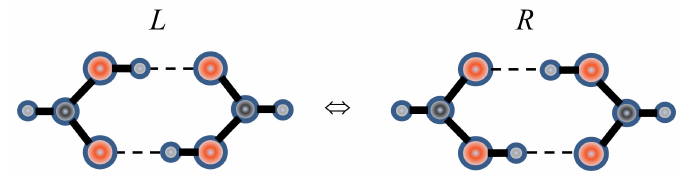
Figure 23. L - and R tautomers in dimer of formic acid.